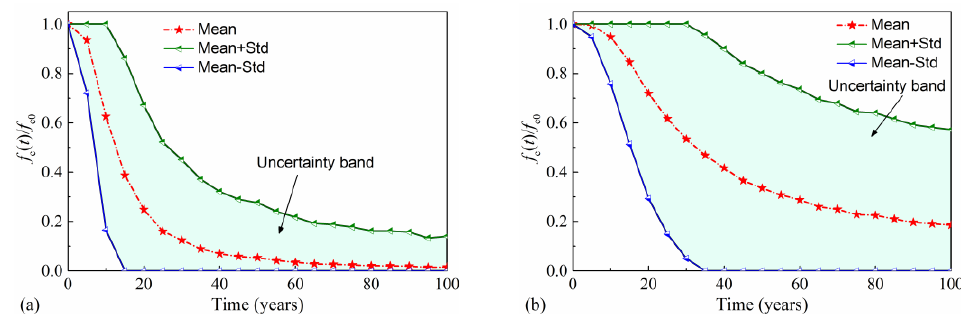
Figure 9. Time-variant NYS of reinforcement: ( a ) splash and tidal zone; ( b ) atmospheric zone. Similarly, the deterioration of concrete is determined with time-variant normalized concrete cover strength (NCCS). NCCS is defined as the concrete strength f c ( t ) at time t normalized by initial concrete strength f c 0 : NCCS( t ) = f y (t)/ f y0 . The mean value of NCCS, mean plus standard deviation (Mean + Std) of NCCS, and mean minus standard deviation (Mean-Std) of NCCS are plotted in Figure 10. From Figure 10a, it is found that the mean NCCS in the splash and tidal zone has dropped dramatically by 87.6% during the first 30 years, which can be attributed to the large probability of concrete cover spalling. Subsequently, the reduction rate of NCCS slows down, and its variability decreases with the increase in service time. By comparing Figure 10a with Figure 10b, it can be found that the reduction of NCCS in the atmospheric zone is less obvious than that of NCCS in the splash and tidal zone. This is due to the smaller mean and standard deviation of the corrosion-initiation time and the higher corrosion current density in the splash and tidal zone than in the atmosphere zone, as shown in Figure 7. After the 100-year service time, the residual mean and the standard deviation of NCCS in the atmospheric zone are 0.186 and 0.387, respectively. The corresponding values in the splash and tidal zone are 0.016 and 0.124, respectively.